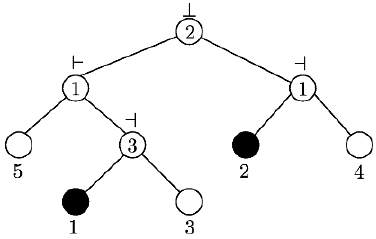
Figure 2. Binary tree with marked vertices representing Φ(5)( u H ) = ( x 5 ‘ 1 ( x 1 a 3 x 3 )) ⊥ 2 ( x 2 a 1 x 4 ) for u and H as on Figure 1.